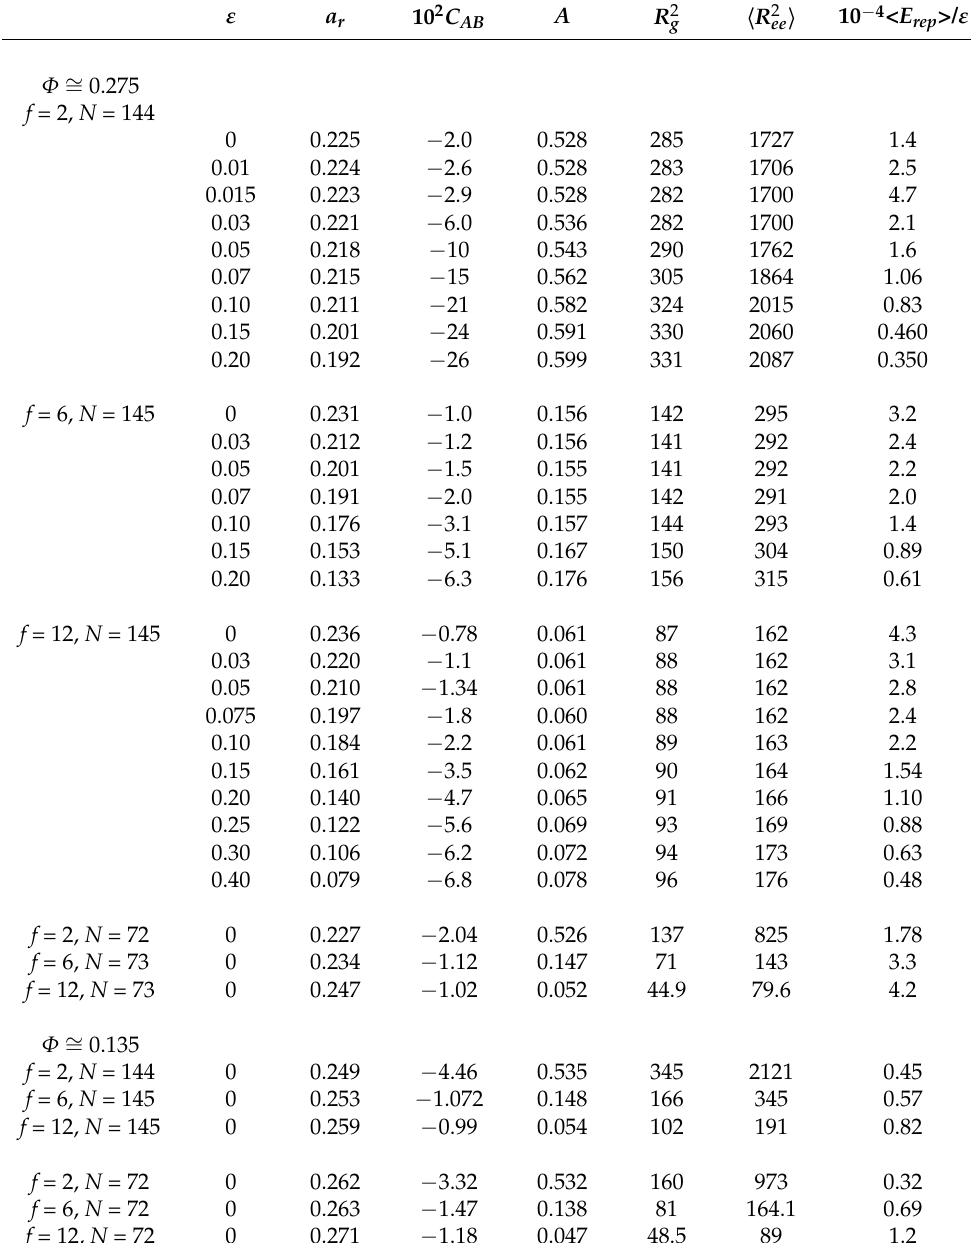
Table 1. Values of conformational properties related to the degree of segregation, type of molecule, density and number of